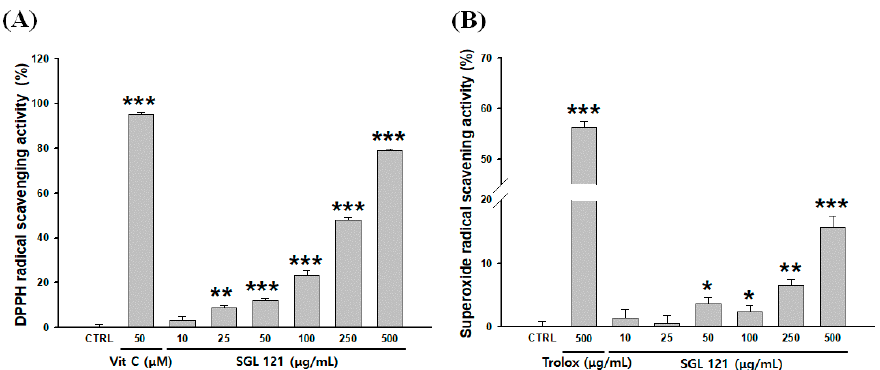
Figure 5. Antioxidant activities of SGL 121 on various radicals determined by ( A ) 2,2-diphenyl-1-picrylhydrazyl (DPPH) radical scavenging activity and ( B ) superoxide dismutase (SOD) radical scavenging activity. Vitamin C (A) and trolox (B) were used as positive controls. Data are presented as the mean ± SD. * p < 0.05, ** p < 0.01, and *** p < 0.001 compared to the control.